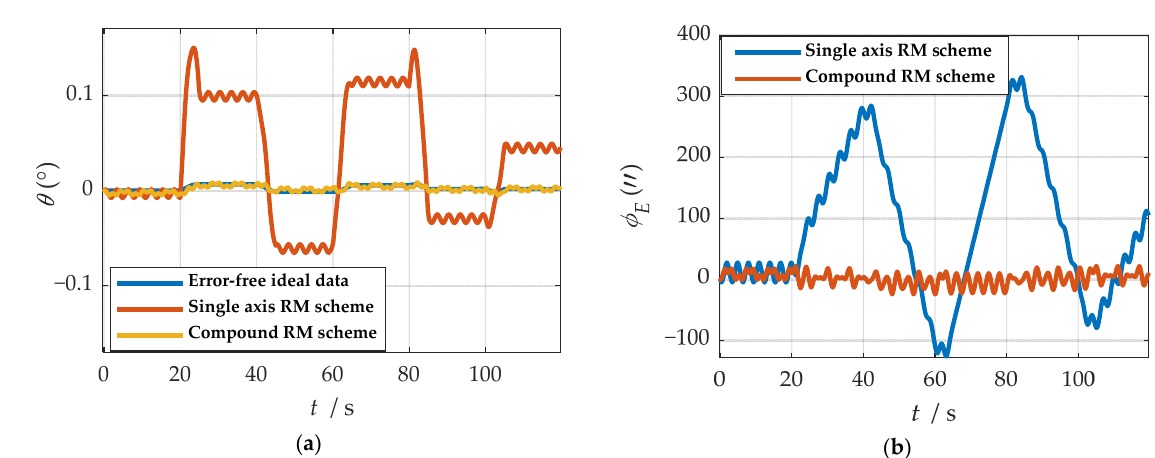
Figure 12. The navigation results comparison of the rotation scheme: ( a ) comparison of calculation results of yaw angle; ( b ) comparison of calculation results of east misalignment angle.